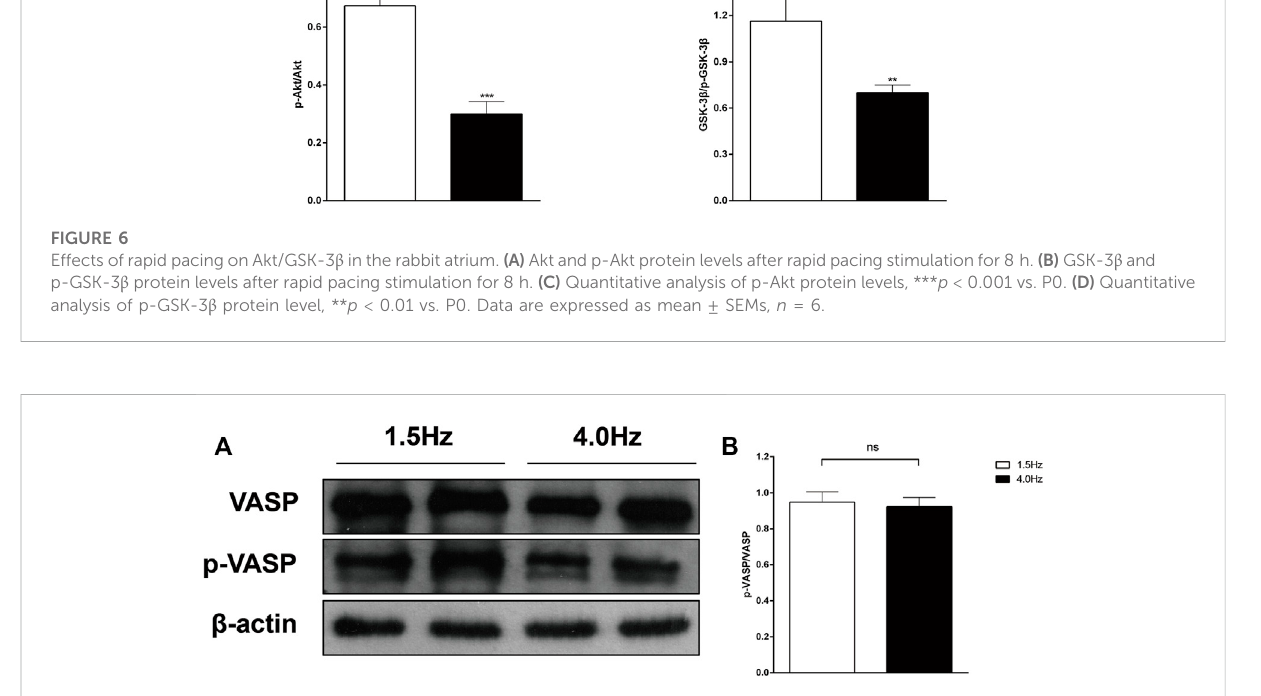
FIGURE 7 VASP-phosphorylation as indicator of cGMP activity. (A) Effect of different stimulation on VASP and p-VASP. (B) Quantitativeanalysis of p-VASP protein levels, p > 0.05. Data are expressed as mean ± SEMs, n =